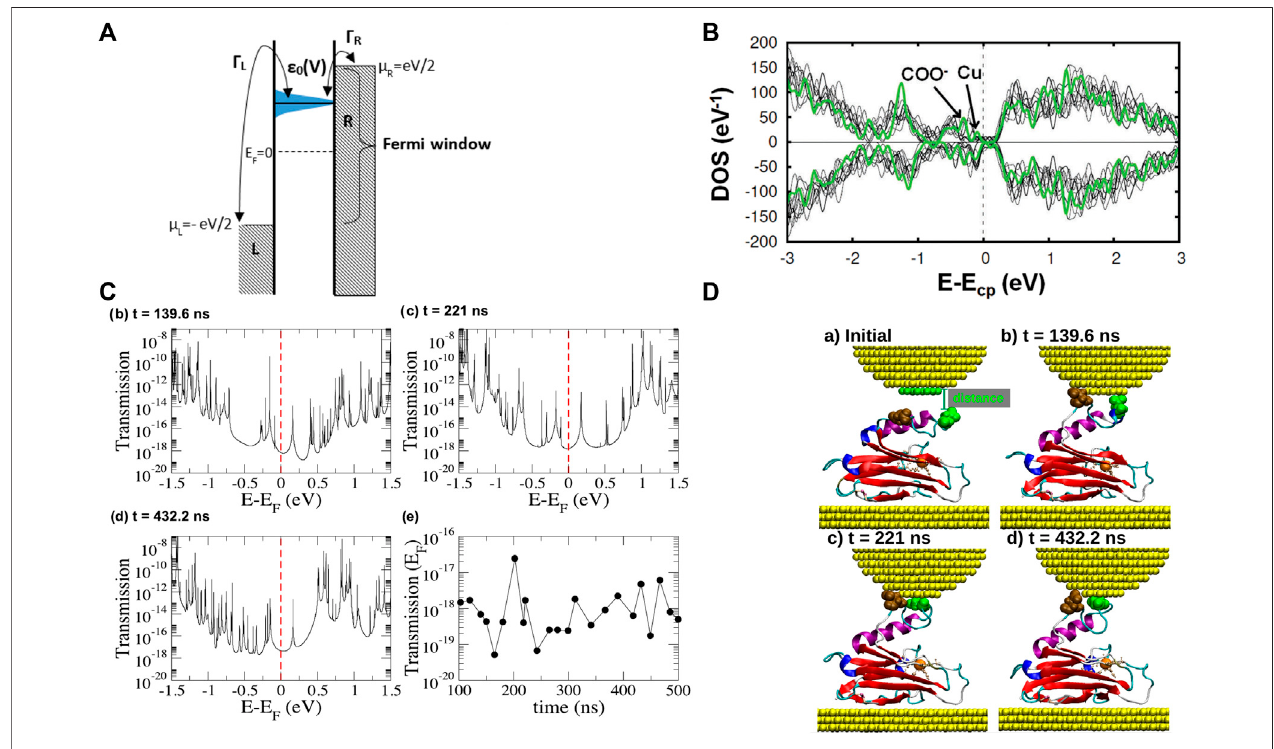
FIGURE 2 | (A) Schematic representation of the Landauer tunneling model [41]; (B) Spin resolved total density of the states of the azurin protein [56]; (C) TransmissionasafunctionofenergyforthreeselectedAu-azurin-AujunctionsobtainedfrommoleculardynamicssimulationsandtransmissionattheFermienergyfor23 representative geometries in the simulated blinking process [58]; (D) geometries corresponding to the transmission curves displayed in panel (C) .